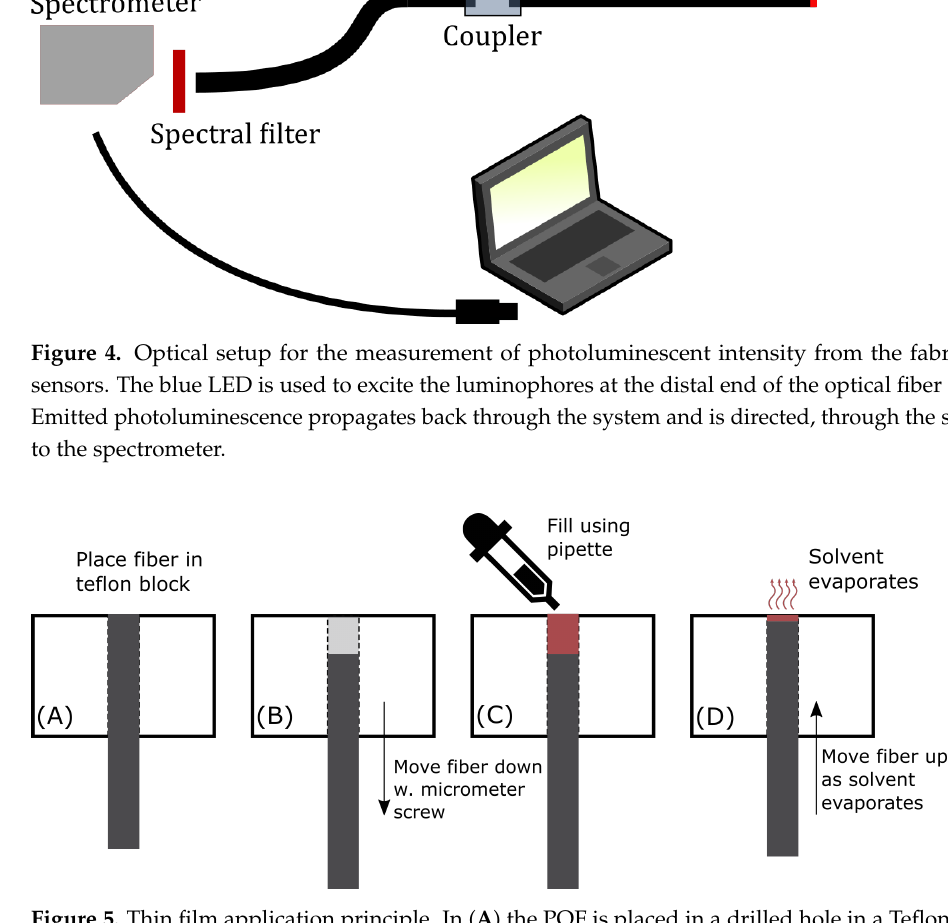
Figure 5. Thin film application principle. In ( A ) the POF is placed in a drilled hole in a Teflon block. A micrometer screw allows for the adjustment of the height of the optical fiber. This is shown in ( B ). In ( C ) a pipette is used to fill the free volume above the fiber and in ( D ) the fiber is slowly moved up, as the solvent